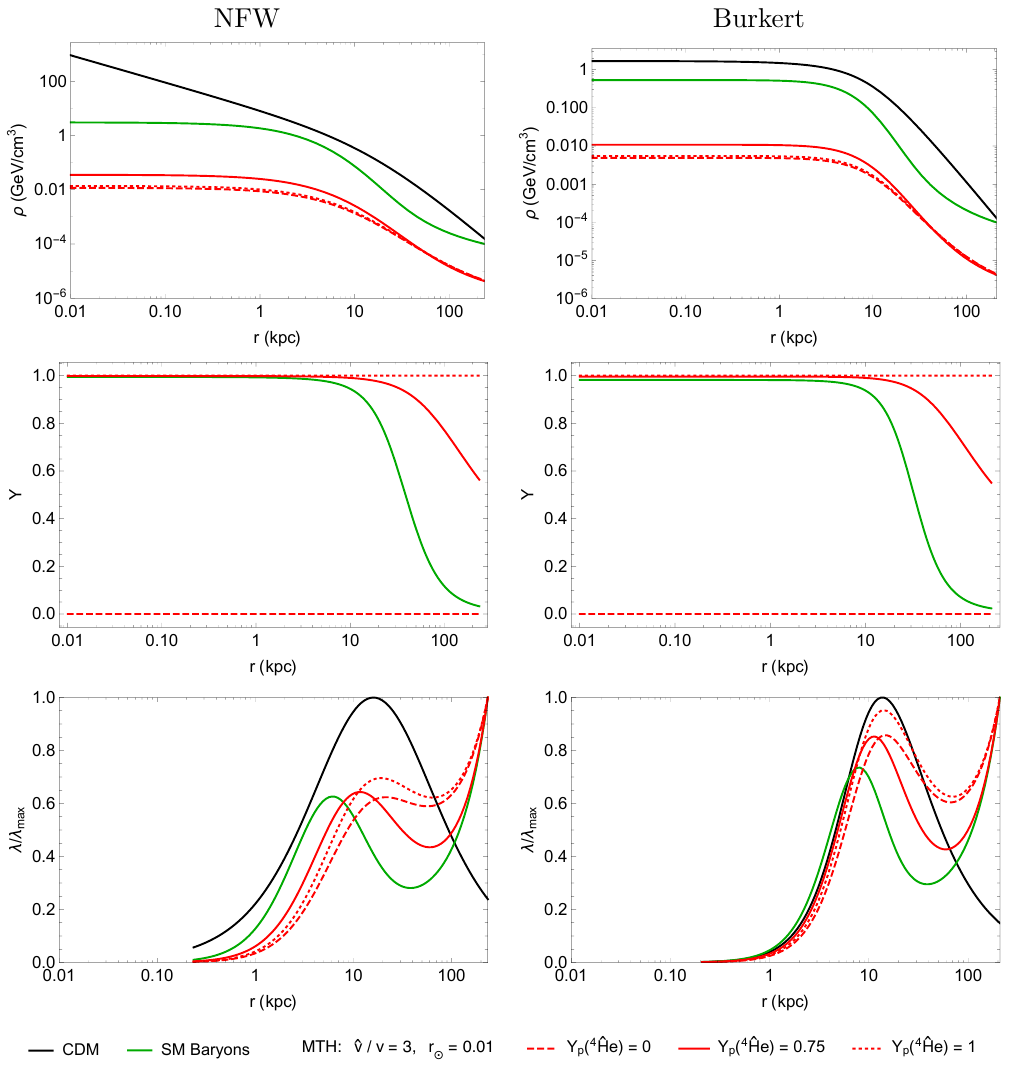
Figure 1 . Top: density profile for the mirror halo benchmarks in table 2, evaluated in the background of the NFW or Burkert CDM Profile. Middle: mirror helium mass fraction ˆ Y ( r ) as a function of r . Bottom: mass density per spherical shell λ = 4 πr 2 ρ ( r ) , normalized to its maximum value for each profile. This shows the distance where most of the constituent atoms are situated. The SM comparison scenario corresponds to evaluating the mirror baryon profile for ˆ v/v = 1 , r = 0 . 2 , Y = 0 . 25 . This is all presented to compare mirror halo parameters to a SM-like halo evaluated under the same assumptions, but does not represent the actual SM baryon distribution